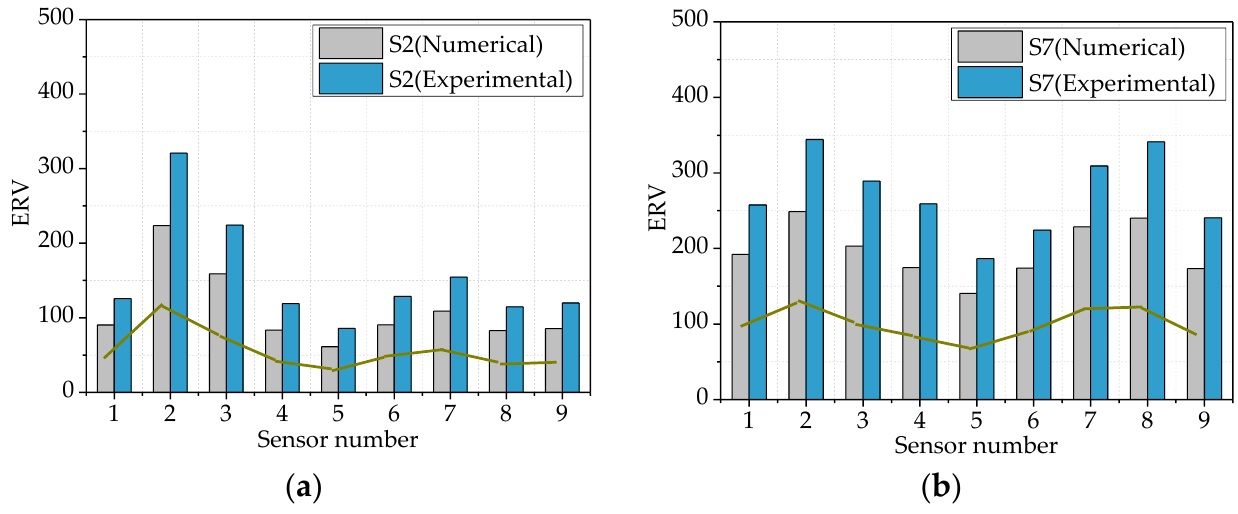
Figure 15. ( a ) ERV value of working scenario S2. ( b ) ERV value of working scenario S7 . After obtaining the energy ratio variation damage index of S2 and S7, the experimental data are used to verify the damage detection effect of CNN on real structures. Firstly, the grid is trained to obtain a sample database, and then the experimental data is used as a test sample for prediction. The final accuracy of the validation set is 91.67%. The network training process and the final detection results of single damage and multiple damage are shown in Figure